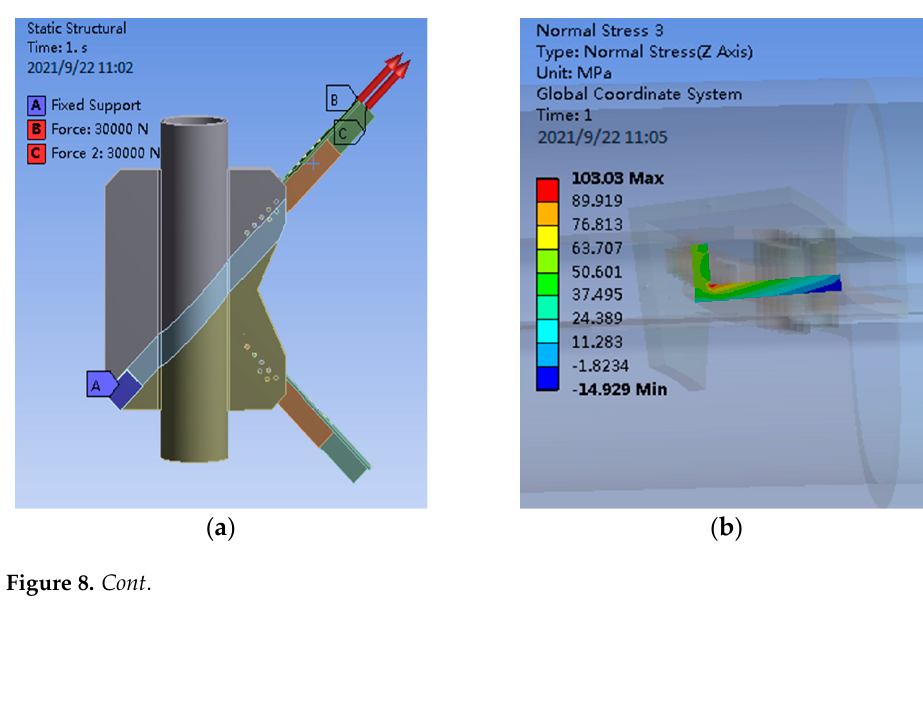
Figure 7. ( a ) Angle steel axle load diagram of PSLSPJ; ( b ) finite element results of PSLSPJ.